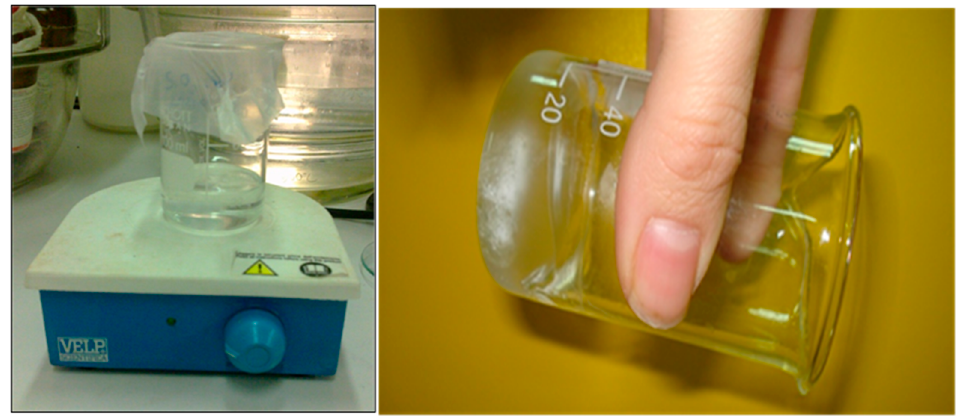
Figure 3. Gel formation of SG- R .